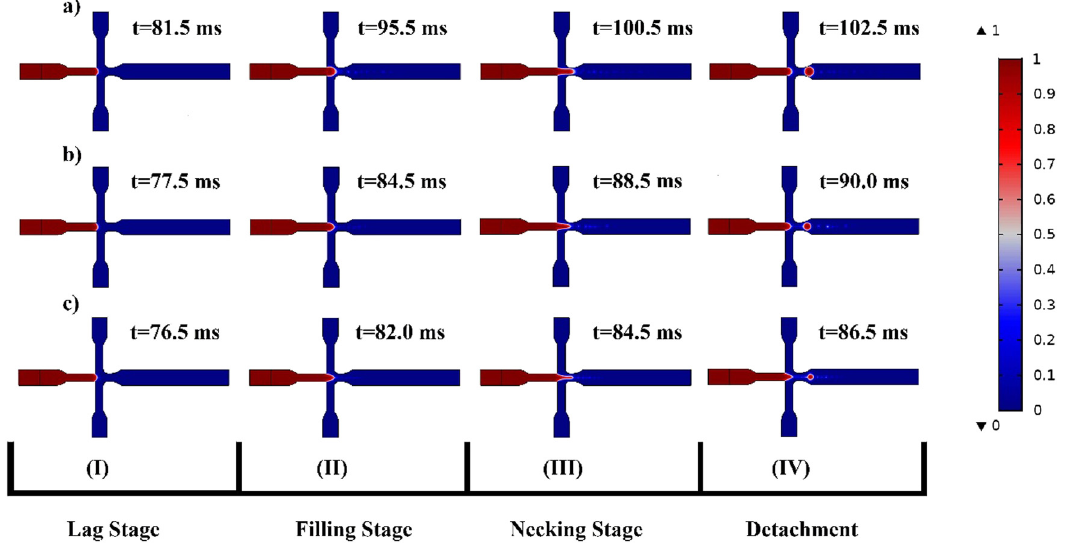
Figure 3: Burst photos of two - dimensional MFFD, pending the implementation of computer simulations of the creation mechanism of composite droplets in micro - conduit. The composite velocity ( V CS ) is 3.3 mm/s, and the vegetable oil velocity ( Vegetable oil ) is equal to 11.1 mm/s. The composite ratios are: ( a ) 0.2%, ( b ) 0.5%, and ( c ) 1.0% ( w/v )